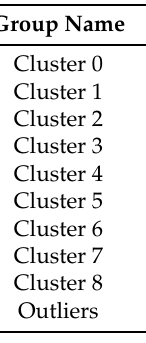
Table 6. Dynamic obesity sub-population groups.